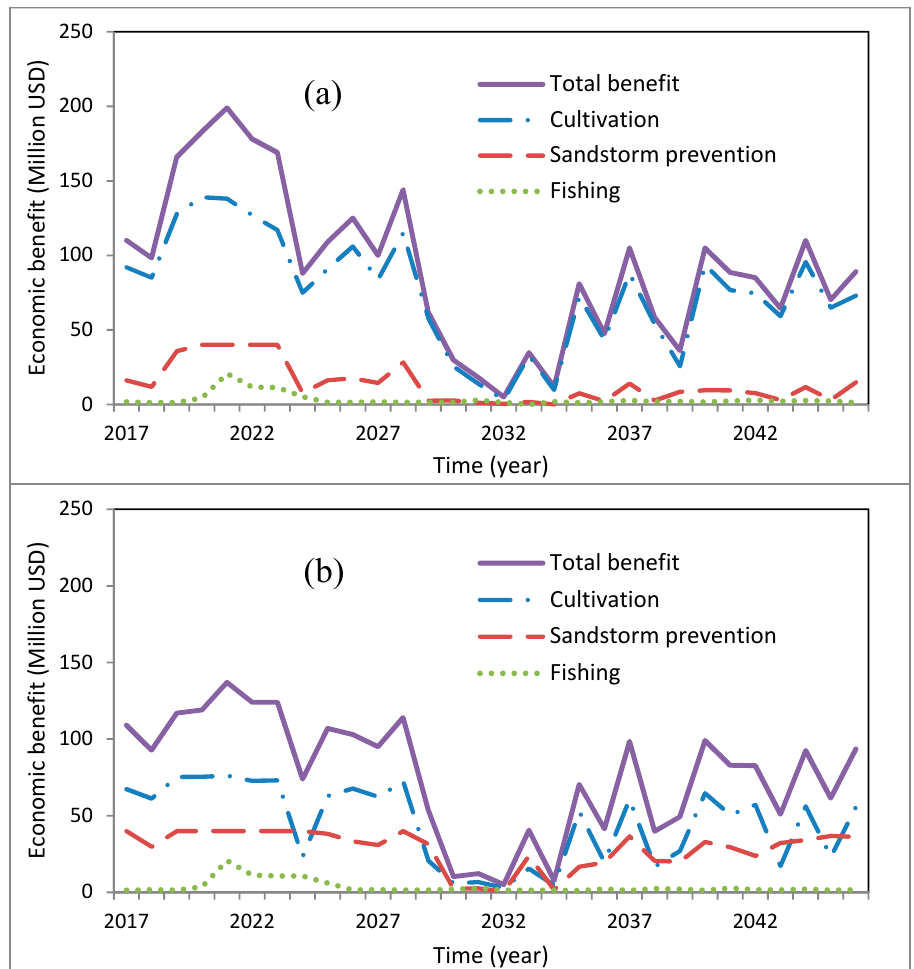
Figure 9. Annual profit from single-objective optimization results for different sectors of agriculture, fishing and soil conservation ( a ) Economic Scenario ( b ) multi-objective Scenario.